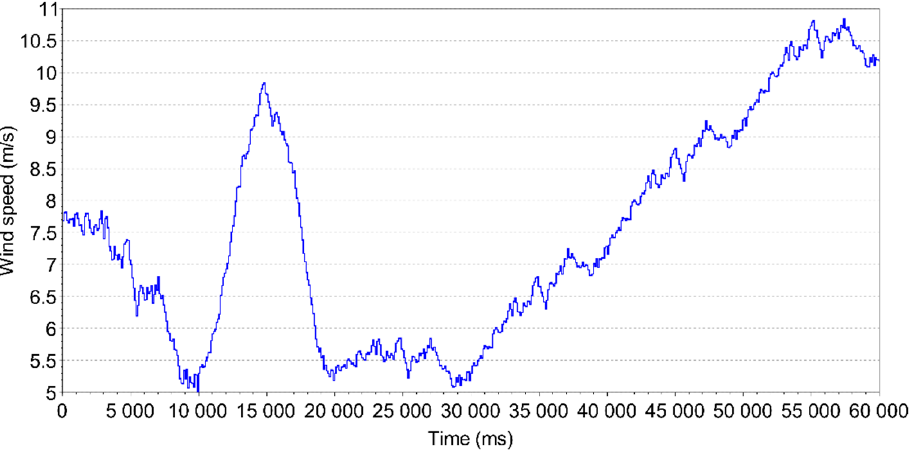
Figure 10. Simulated wind speed.